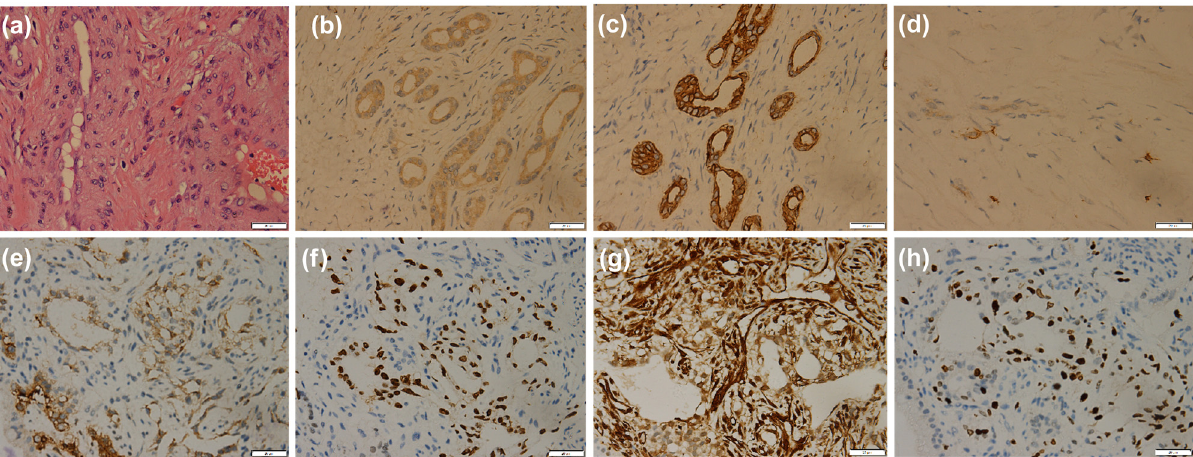
Figure 3: Hematoxylin - eosin staining ( a ) , 40 times magni fi cation: microscopically, there were obviously degenerate fusiform and ovoid tumor cells with loose reticular arrangement, hyperchromatic nuclei, inconsistent cell sizes, and can see the fat composition between the cells. Immunohistochemical staining showed tumor cells positive for AFP ( b ) , CK ( c ) , CD117 ( d ) , glypican - 3 ( e ) , SALL4 ( f ) , vimentin ( g ) , and Ki - 67 ( h )